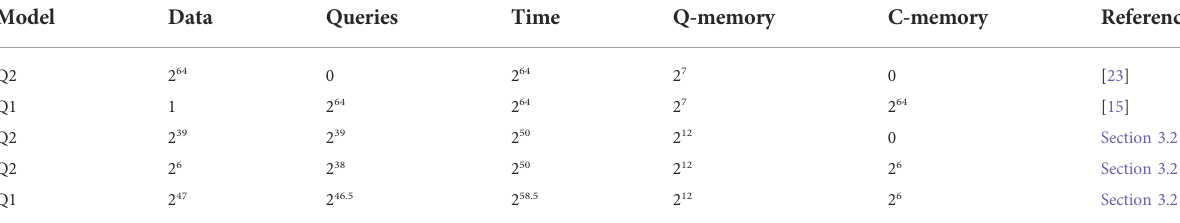
TABLE 3 Comparison of quantum attacks against 2-step LED-128.